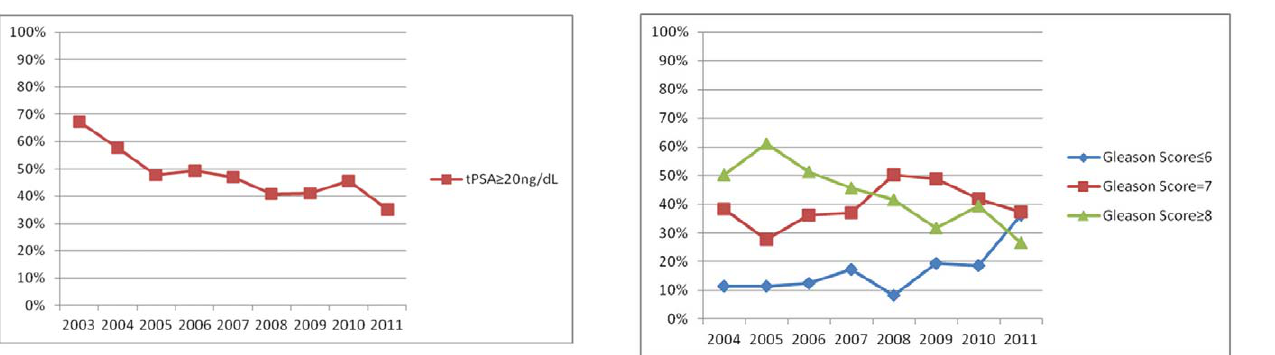
Figure 2. Trends of Gleason Score # 6, =7, $ 8 Groups over the years. The percentage of $ 8 group trend to go downwards from 50% in 2004 to 27% in 2011 ( P trend =2.08 6 10 2 7